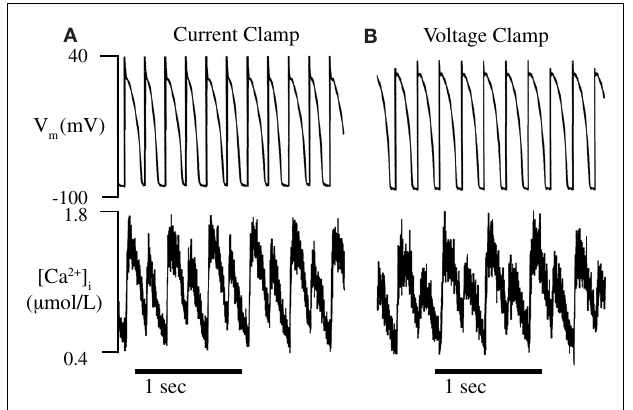
FIGURE 6 |Alternans can be caused by intrinsic Ca 2 + -cycling dynamics alone. The intracellular Ca 2 + transients of paced (A) and AP clamped (B) isolated rabbit ventricular myocytes are observed using a fluorescent Ca 2 + -sensitive dye (fura-2). (A) As expected, the APDs and Ca 2 + transients of paced myocytes are seen to alternate from beat-to-beat when the cycle length is reduced to below a critical threshold (180ms). (B) The Ca 2 + transients of AP clamped myocytes were still seen to alternate below approximately the same cycle length threshold as paced myocytes, in spite of fixed membrane voltage.This indicates that Ca 2 + -cycling dynamics can alternate due to their own, intrinsic instability and has led many to conclude that Ca 2 + -dynamics are solely responsible for cellular alternans. Adapted from Chudin et al. (1999). rhythm is replaced by another with twice the period. In this case,